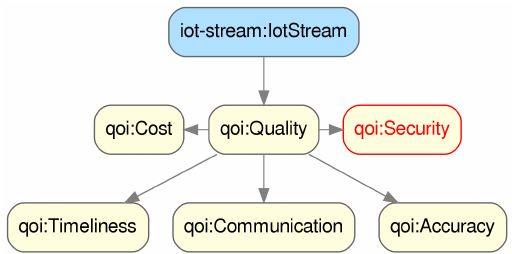
Figure 8. IoTCrawler ontology detail, showing the qoi:Security dimension